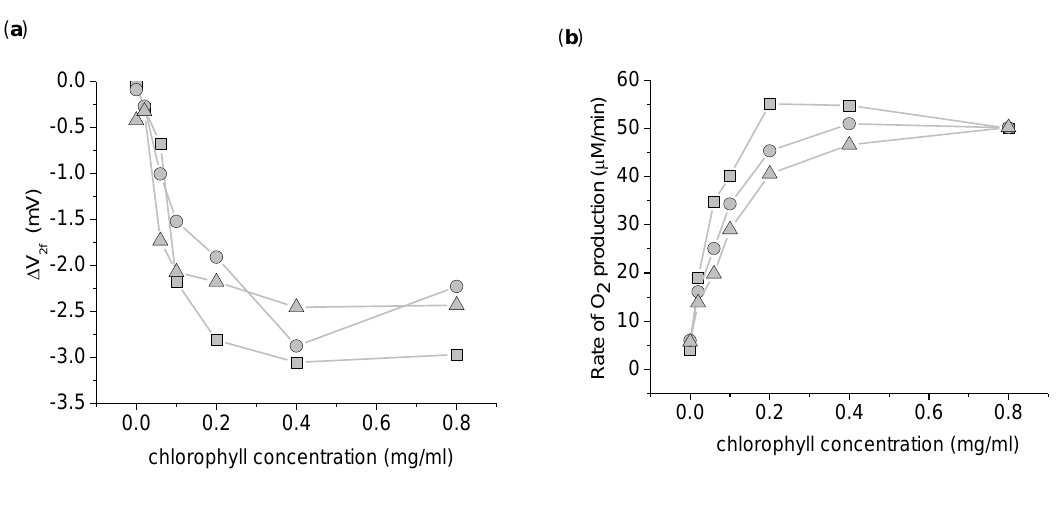
Figure 4. Dependence of the 2nd harmonic response to thylakoid concentration. (a)  V 2f taken with a 3,072 Hz, 8 V sinusoid driving voltage. (b) Rate of increase in O pp 2 concentration. This data was taken simultaneously with  V . This experiment was done in 2f triplicate, with each symbol (circle, square, and triangle) representing a different replicate per chlorophyll concentration. The background O absorption from the atmosphere was 2 corrected for in this data by measuring the rate of O increase of the buffer in the dark 2 for 1 min before and after the light exposure. The background O absorption was taken to 2 be the average of the two dark measurements. Measurements use 5 mL suspension buffer with 1.0 mM K Fe(CN) 3 6